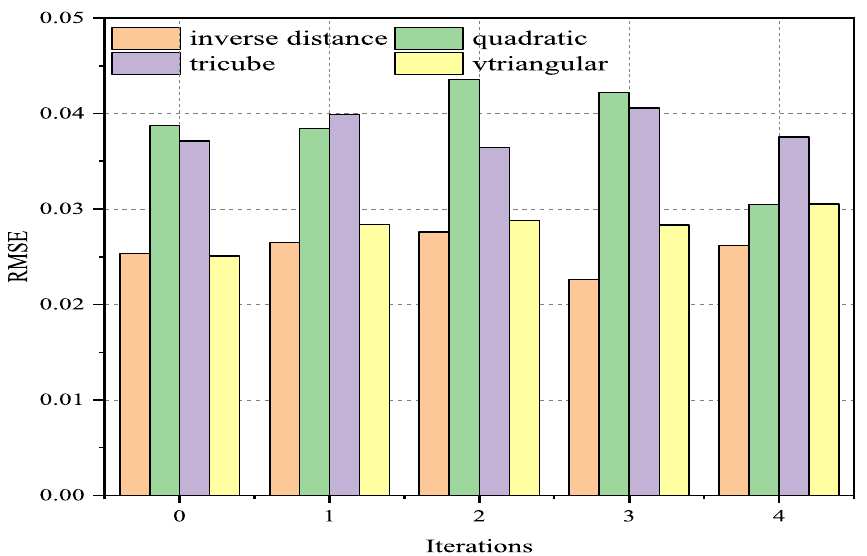
Figure 4. Prediction error with different weight